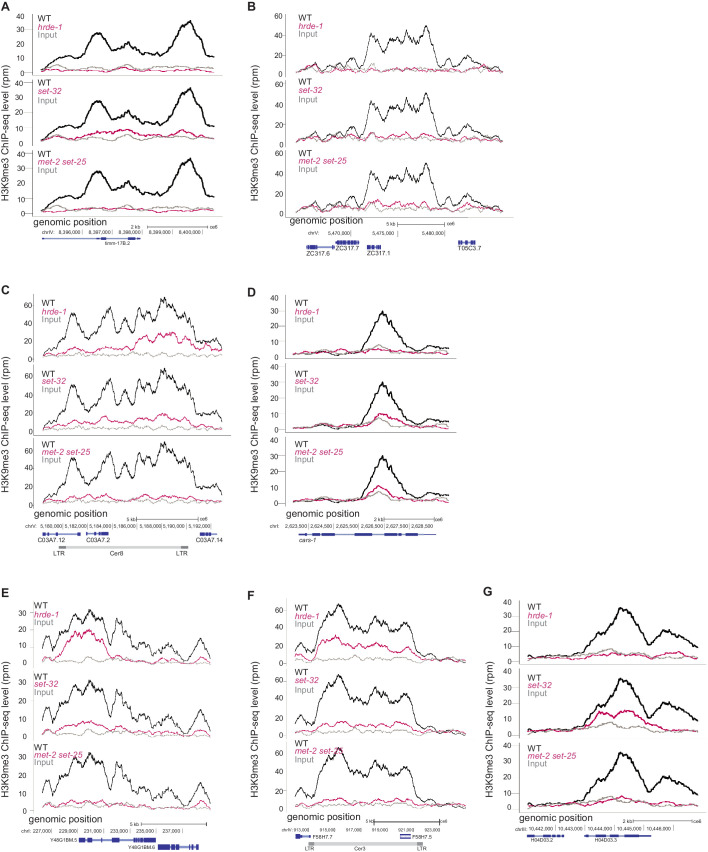
Genetic requirements for H3K9me3 at additional loci.(A–G) H3K9me3 levels (y axis) are plotted as a function of genomic position along the x axis in three mutant strains. Top panel: hrde-1, middle panel: set-32, bottom panel: met-2 set-25. For each panel WT is plotted in black, mutant is plotted in pink, grey is input in WT. The genomic loci are as follows: (A) D2096.1, a top set-32-dependent gene, (B) an exemplary GRH locus on chromosome V:5465000–5485000, (C) Cer8, (D) Y23H5A.7a, a top hrde-1-dependent gene, (E) Cer12, (F) Cer3, and (G) H04D03.3, a top set-32-dependent gene. All signals normalized to sequencing depth.